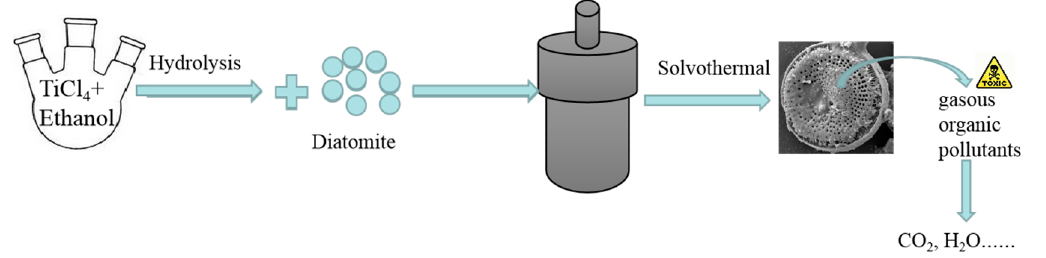
Figure 8. Synthesis procedure for XTiO 2 @diatomite catalysts.